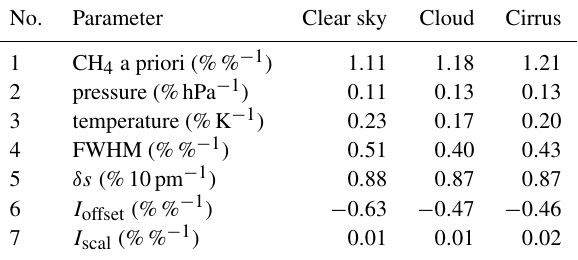
Table 1. CO column retrieval sensitivity in % with respect to the uncertain knowledge of a set of atmospheric and instrument param- eters for the generic clear sky, cloud and cirrus ensemble: (1) CH 4 a priori uncertainty of TM5-NOAA runs, (2) ECMWF surface pres- sure uncertainty, (3) ECMWF temperature profile offset, (5) FWHM uncertainty of the ISRF, (6) spectral calibration error δs and (7) the radiometric offset I offset and a multiplicative radiometric error I scal of the level 1 data